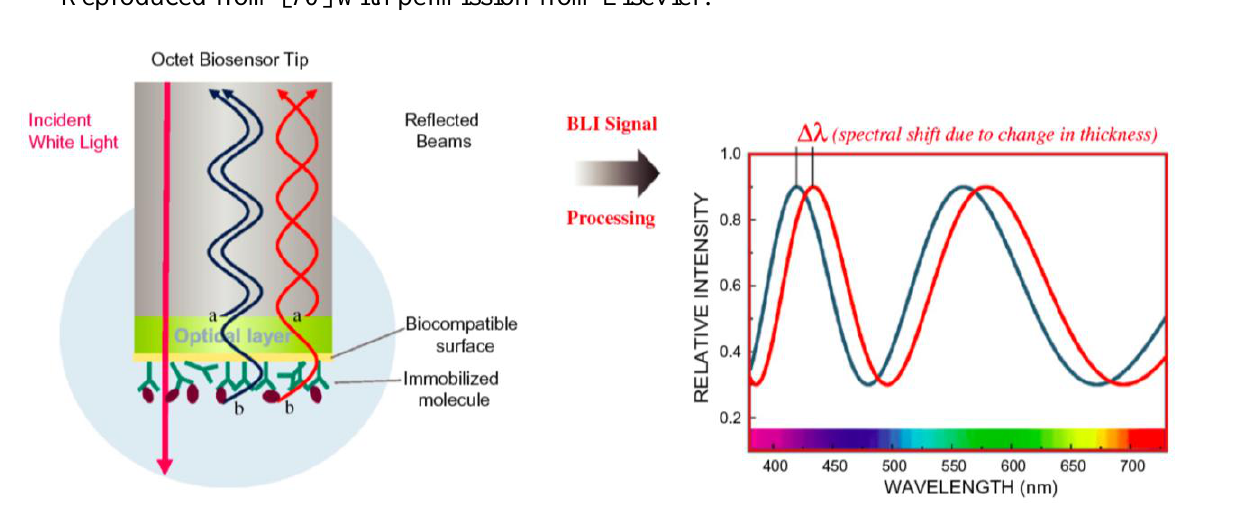
Figure 6. An optical fiber used for Bio-Layer Interferometry and a typical optical signal. Reproduced from [70] with permission from